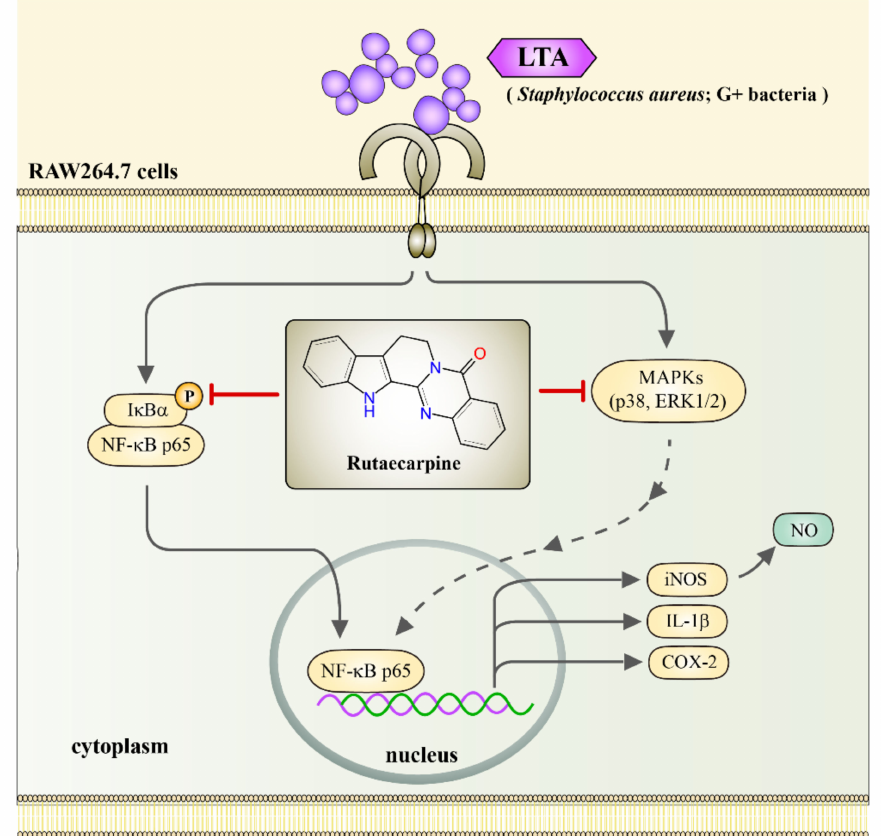
Figure 6. The schematic illustration indicates the inhibitory mechanism of Rut in LTA-stimulated RAW cells. LTA binds to its receptor, induces I κ B α / NF- κ B p65 and ERK/p38 phosphorylation, followed by inducing NF- κ B p65 nuclear translocation. The translocated NF- κ B p65 in turn activates iNOS, IL-1 β , and COX-2 expression, iNOS ultimately induces NO production. Rut inhibits LTA- induced production of NO, expression of COX-2, IL-1 β , and iNOS, phosphorylation of p38/ ERK1/2, and I κ B α / NF- κ B p65, and nuclear translocation of NF- κ B p65 in RAW cells, eventually exerts its anti-inflammatory